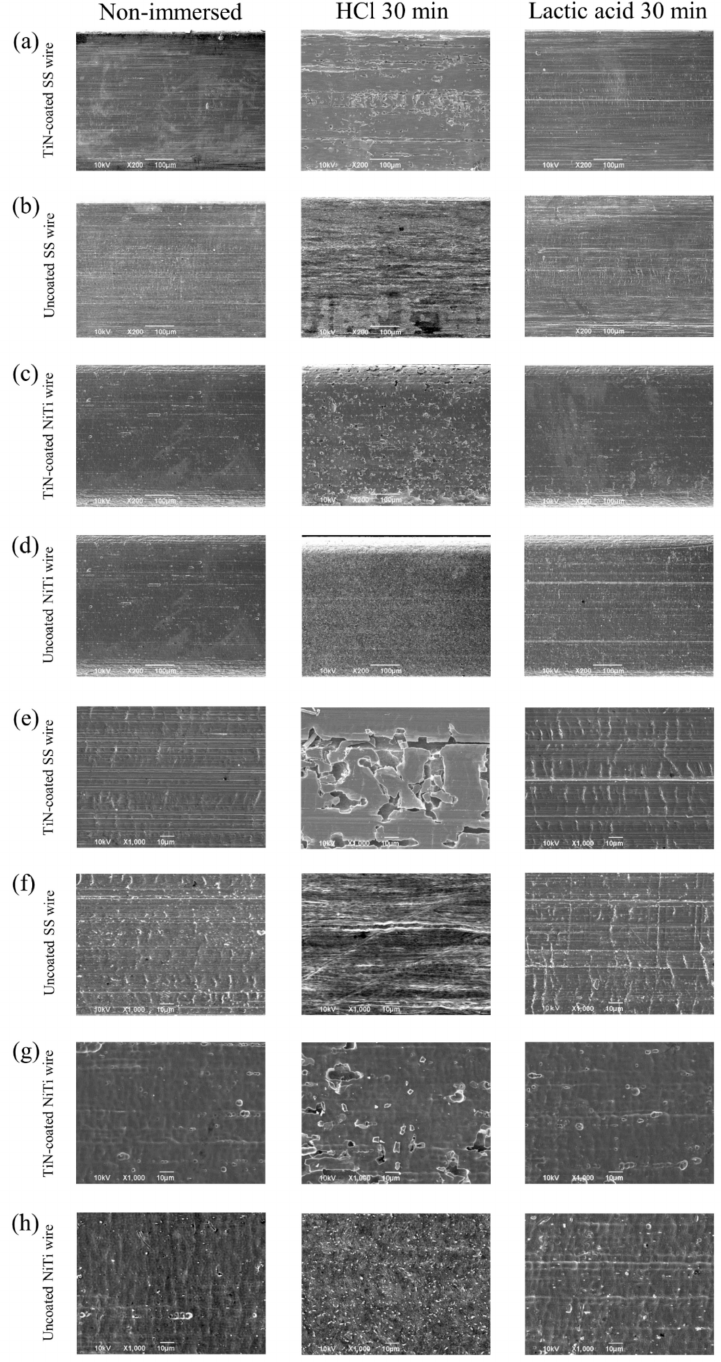
Figure 4. Scanning electron micrographs of orthodontic arch wire immersed in HCl or lactic acid for 30 min. ( × 200): ( a ) TiN-coated SS wire; ( b ) Uncoated SS wire; ( c ) TiN-coated NiTi wire; ( d ) Uncoated NiTi wire. ( × 1000): ( e ) TiN-coated SS wire; ( f ) Uncoated SS wire; ( g ) TiN-coated NiTi wire; ( h ) Uncoated NiTi